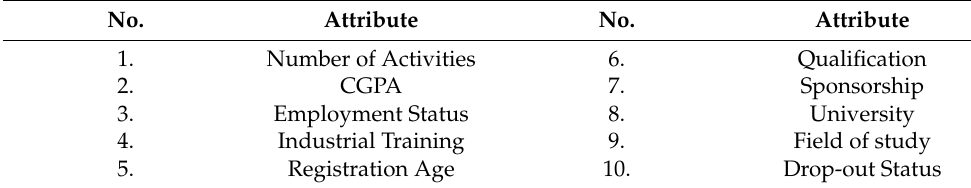
Table 4. Model A (StandardScaler and supervised feature selection).